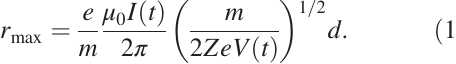
FIG. 4. The values of (a) E ⊥ and (b) voltage as functions of position in the AK gap in the inner MITL ( r ¼ 10 cm) for the simulation geometry in Fig. 2(a). The results without particles are shown in red and results with electrode plasma formation are shown in blue. The values are extracted during the pulse rise [60 ns in the current pulse shown in Fig. 2(a)].